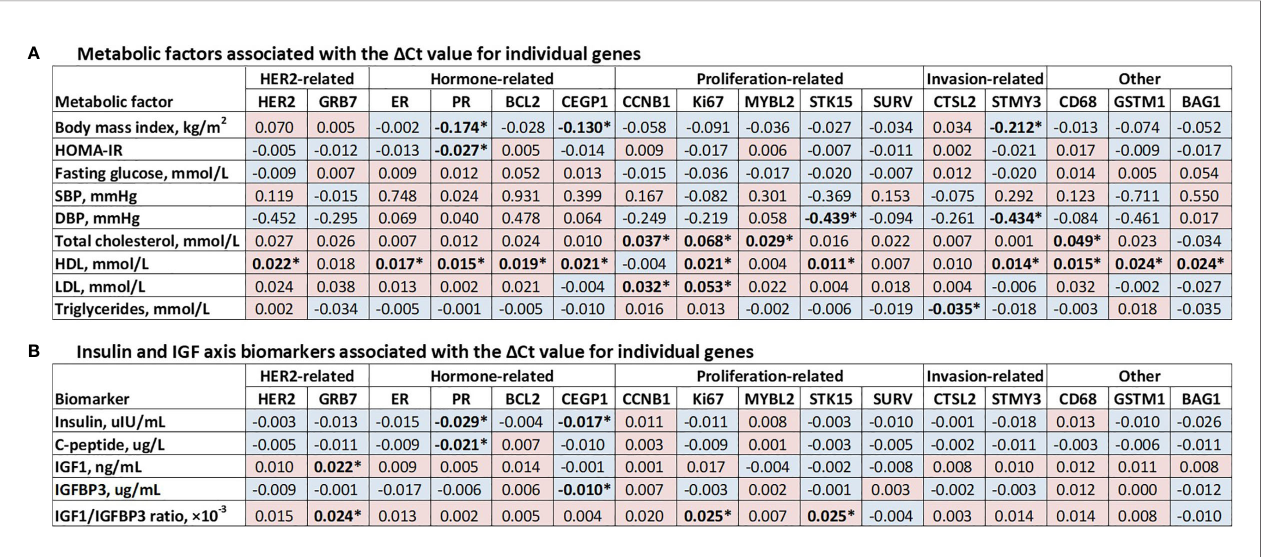
FIGURE 1 | Associations of the D Ct value for the 16 cancer-related genes with metabolic factors and insulin and the IGF axis biomarkers. (A) Associations of the D Ct value for the 16 cancer-related genes with metabolic factors; (B) Associations of the D Ct value for the 16 cancer-related genes with insulin and IGF axis biomarkers. Data are b estimates with adjustment for age and postmenopausal status (yes, no). Blue cells represent inverse associations and pink cells positive associations, with a statistical signi fi cant association marked by asterisk (*). Concentrations of HOMA-IR, IGF1, IGFBP3, IGF1/IGFBP3 ratio, insulin, and C-peptide were log transformed to improve the normality of their